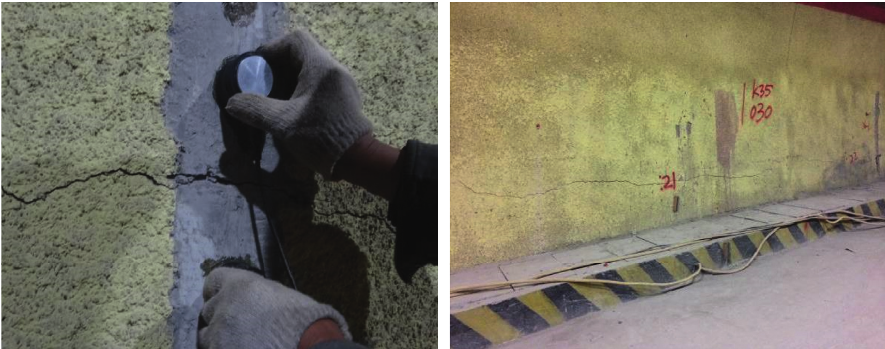
Figure 8: Longitudinal cracks of secondary tunnel lining.